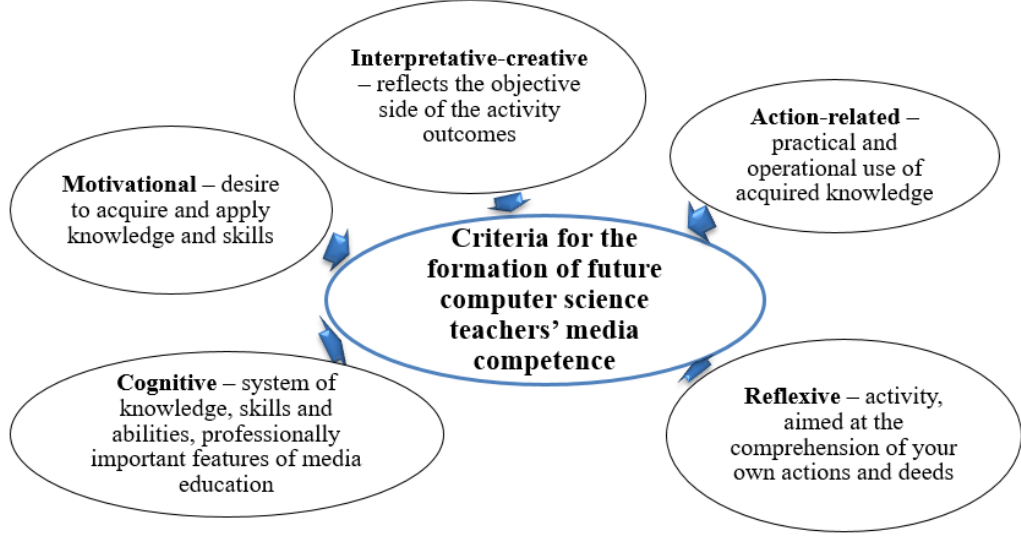
Figure 77: Presentation of paper